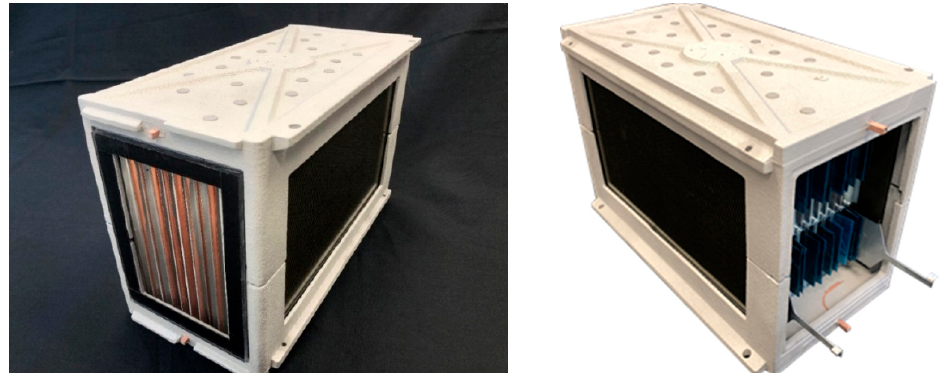
Figure 9. Demonstrator assembly: ( a ) positioning of the cell stack in the joining device; ( b ) assembly of the module shells.